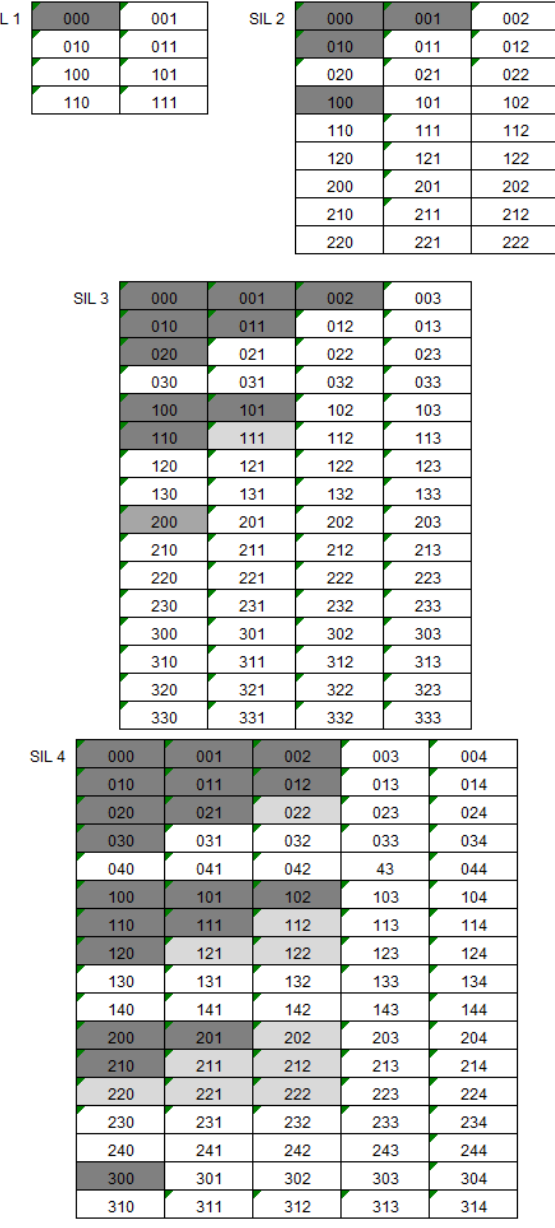
Fig. 4. Three-elements SIL AND